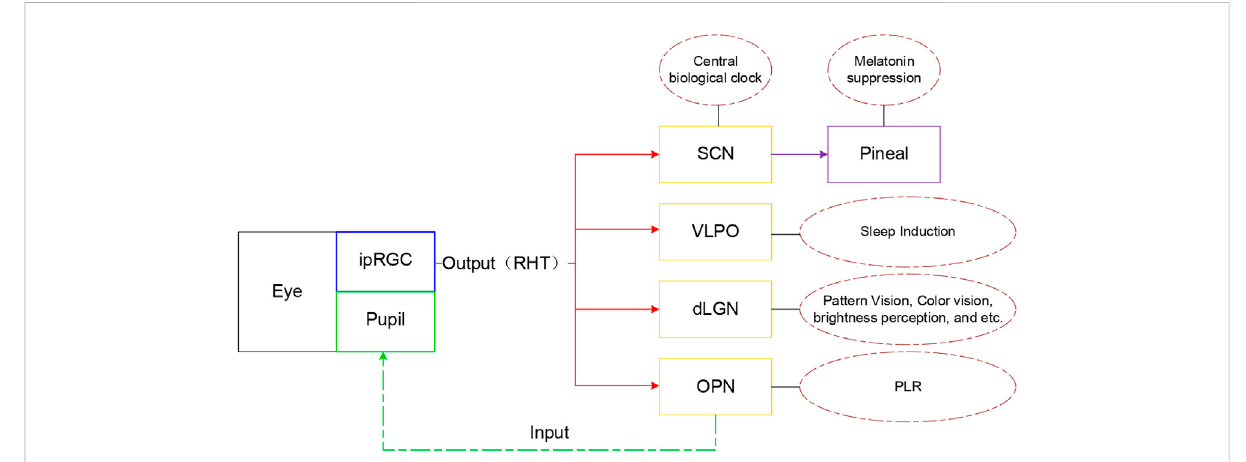
FIGURE 2 Diagram of brain regions projected by ipRGC and their function (Zhao et al.,